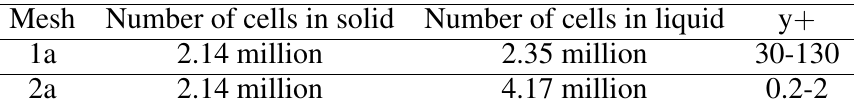
Table 1: Information regarding the number of cells and y + for the meshes generated